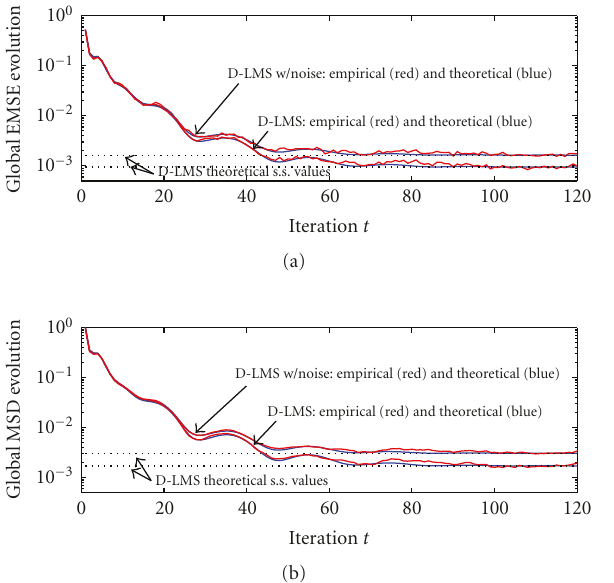
Figure 4: Global performance evaluation for a time-varying parameter.